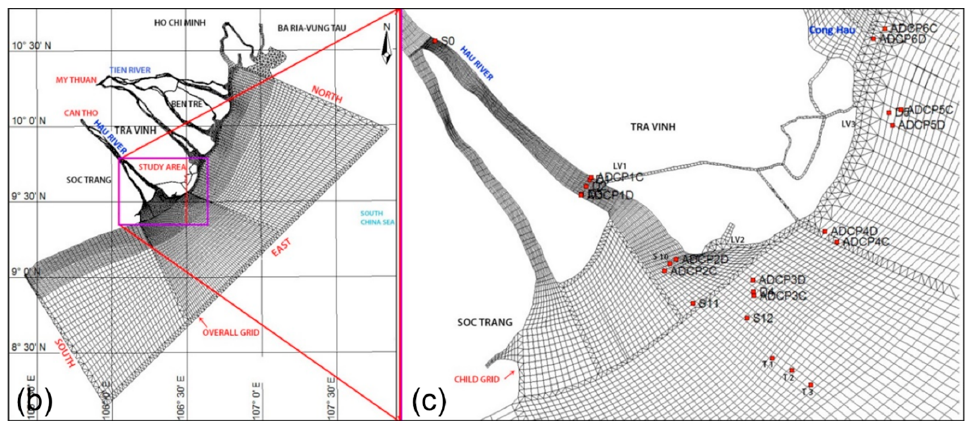
Figure 2. Study location of Hau River mouth with locations of the river and sea boundaries of the model. ( a ) Study stations and cross-section; ( b ) parent overall grid and ( c ) child grid. On the Hau River, water river discharge is reduced by branching upstream, and seasonal variation is diminished by the influence of the upstream flow [46,47]. The annual discharge of the Hau River ranges from 5000 to 12,000 m 3 s − 1 at Can Tho Gauge Station (Figure 1). During high flow, freshwater can extend to the mouth of the Dinh An, whereas during low flow, seawater has been observed to penetrate about 50 km landward of the mouth [30,32,35,47].